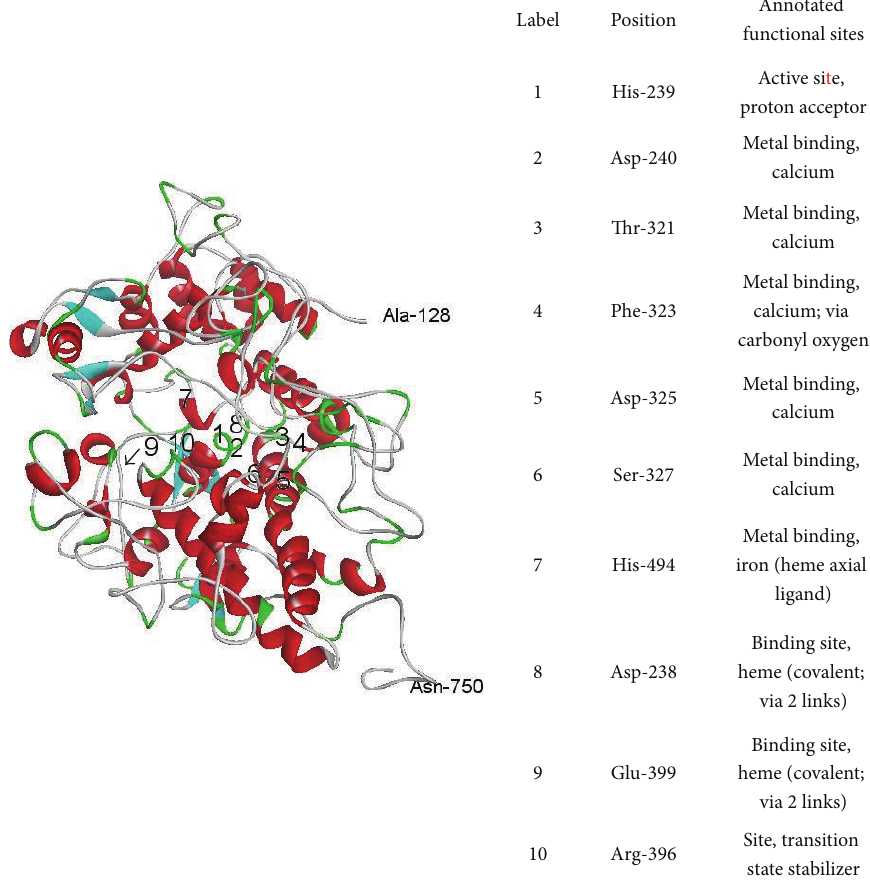
Figure 4: Homology model of the wild type human TPO using sheep lactoperoxidase as a template (PDB 2IKC). The positions of the annotated functional site referred from UniProt database (reference number: P07202). The arrow indicates the positions of the mutated residue